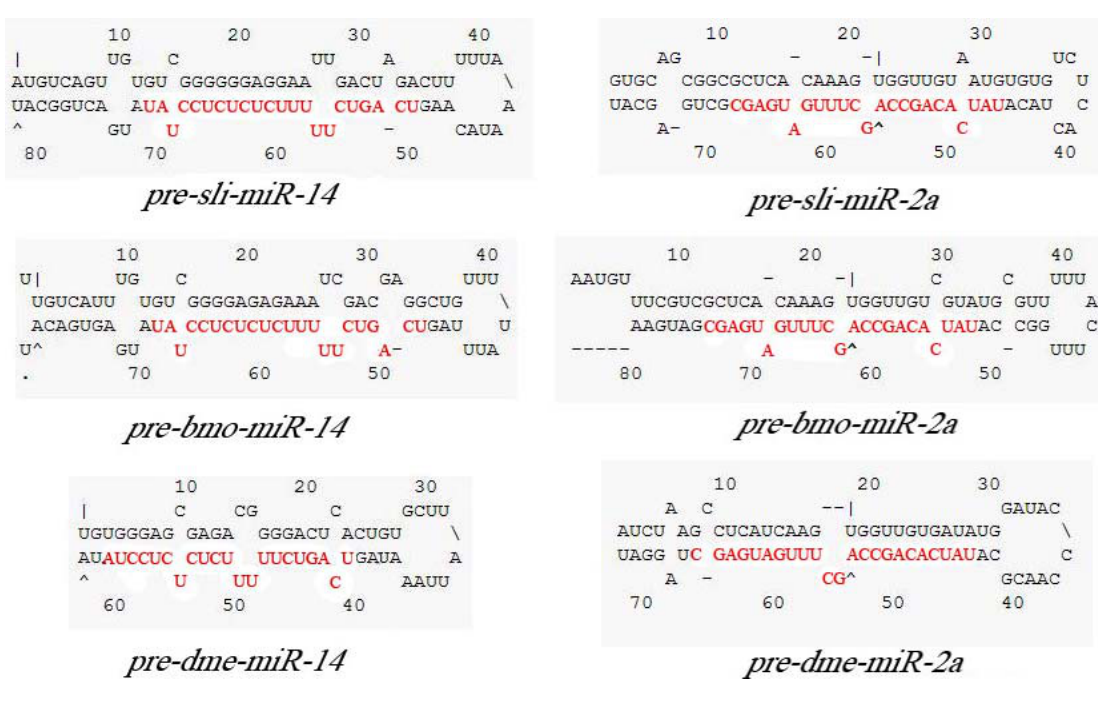
Figure 4. The stem-loop structures of precursors and mature forms (highlighted in red) of miR-14 ( a ) and miR-2a ( b ) in S. litura , B. mori and D. melanogaster .